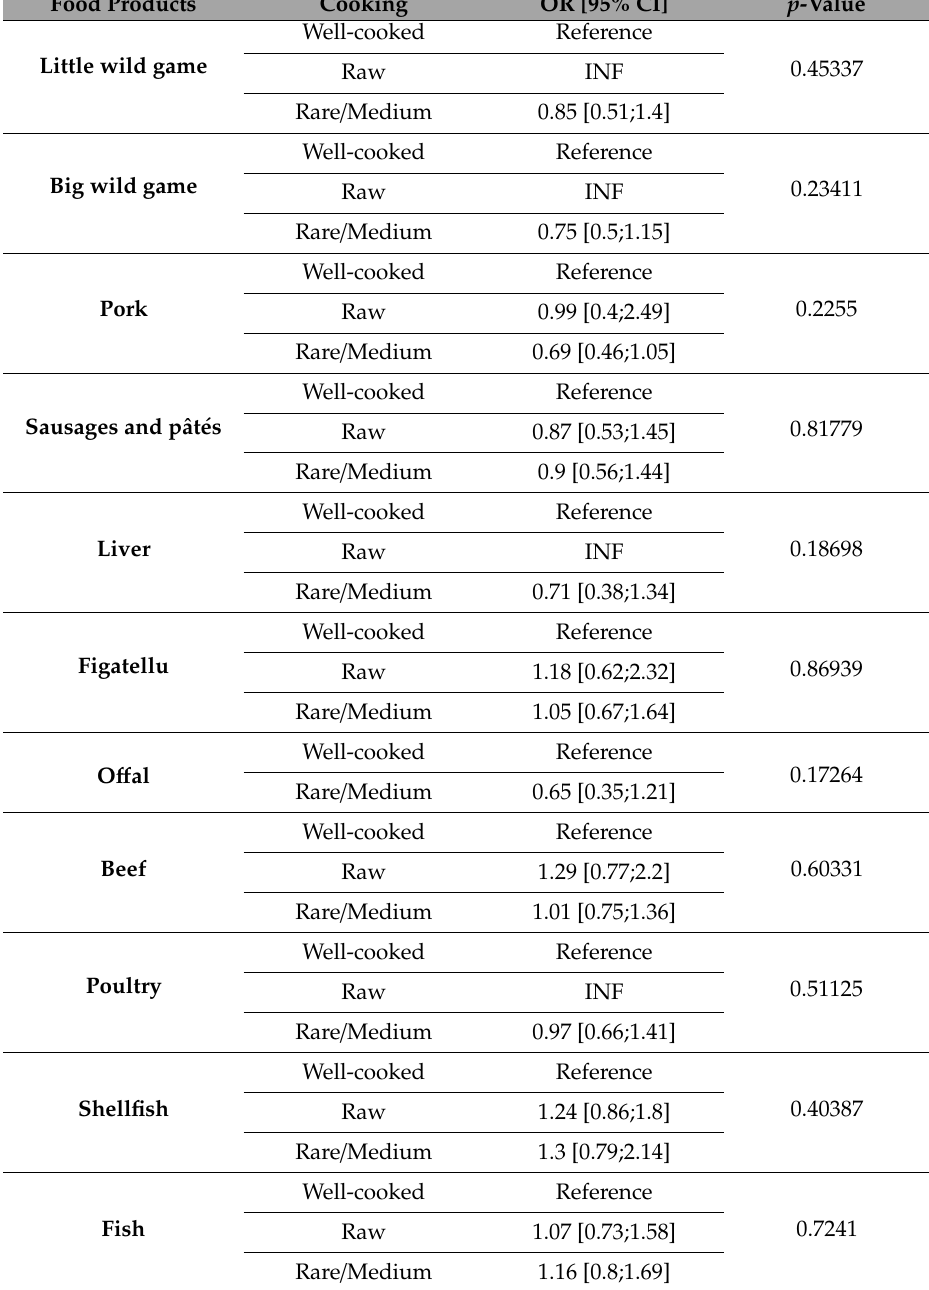
Table A2. Univariate analysis of the association between anti-HEV IgG detection and the type of